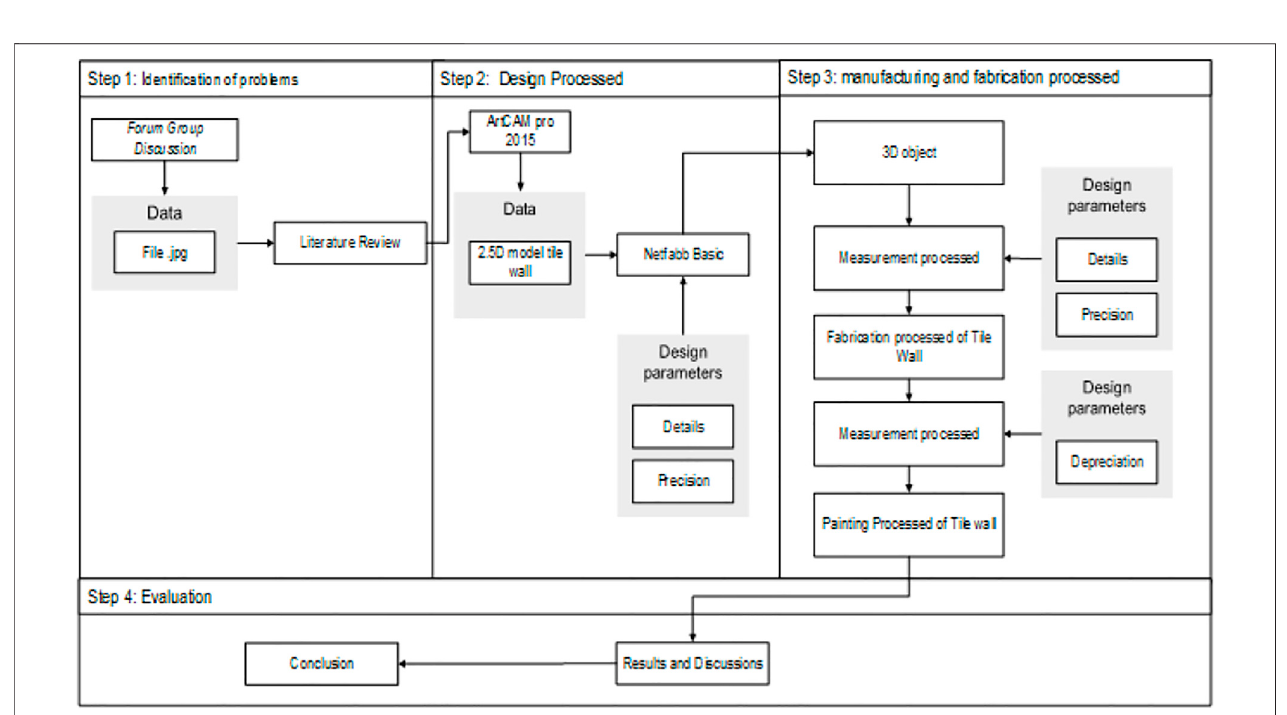
FIGURE 7 | Flow chart of the CARE System applied to design and manufacture Islamic ceramic wall tiles in this study.